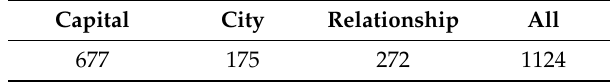
Table 2. Chinese word analogy dataset, which contains three analogy types: capitals of